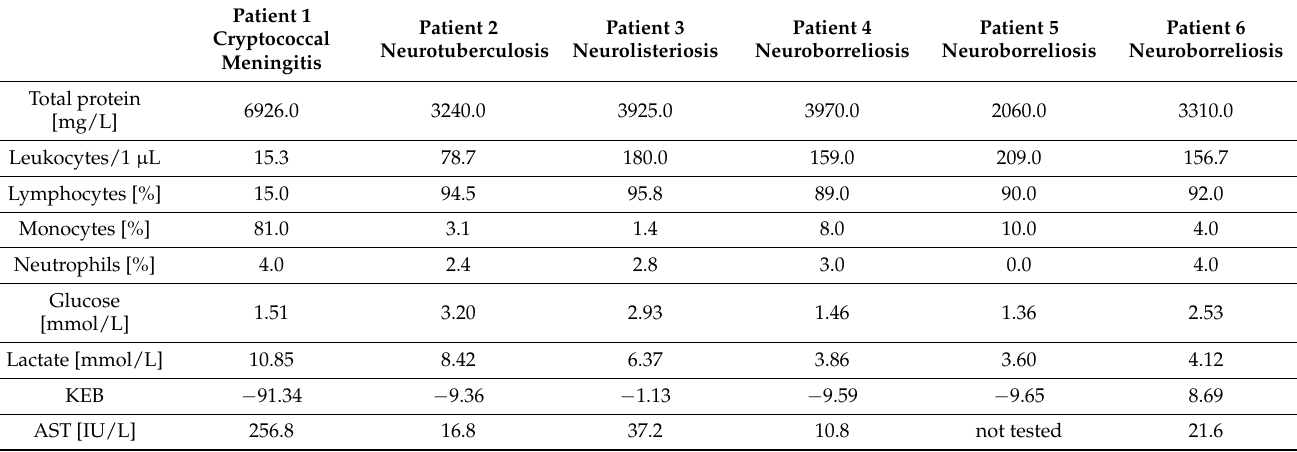
Table 1. A review of CSF analysis in several patients with neuroinfection caused by intracellular bacteria and